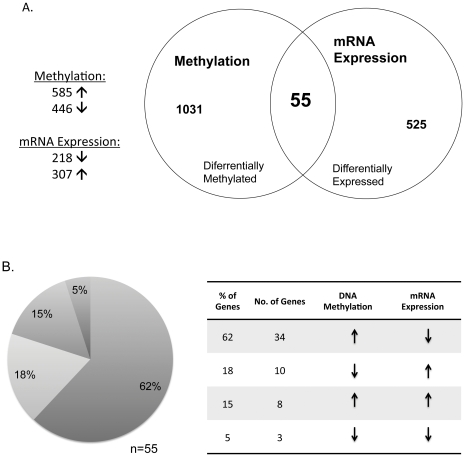
Integration of DNA methylation and mRNA expression data in uterine leiomyoma and matched myometrial tissues.(A) The Venn diagram integrates the number of differentially DNA methylated genes with the number of differentially expressed genes in leiomyomas compared to myometrial tissues. Approximately 55 genes showed changes in methylation status and expression. (B) A total of 34 (62%) of the genes were hypermethylated and downregulated, 10 (18%) were hypomethylated and upregulated, 8 (15%) were hypermethylated and upregulated and 3 (5%) were hypomethylated and downregulated.